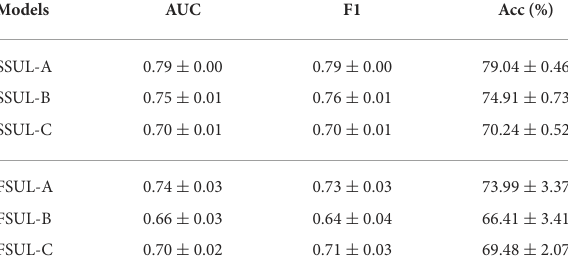
TABLE 3 Self-supervised SSUL-* and fully supervised FSUL-* downstream task performances on EEG data using H EEG branch. Models